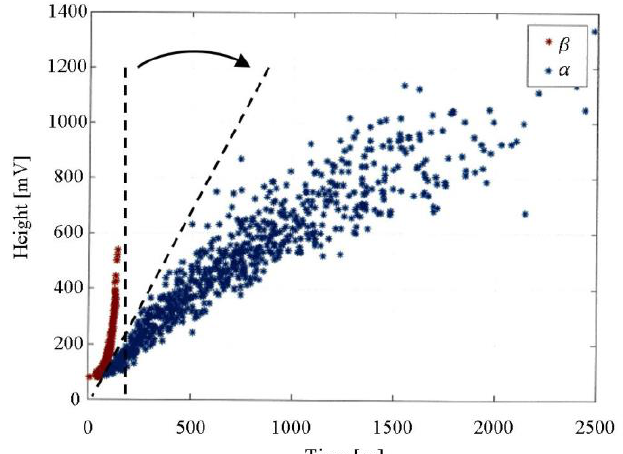
Fig. 7. The distribution of the alpha and beta pulses over the amplitude-decay time span in a single SiPM detector.